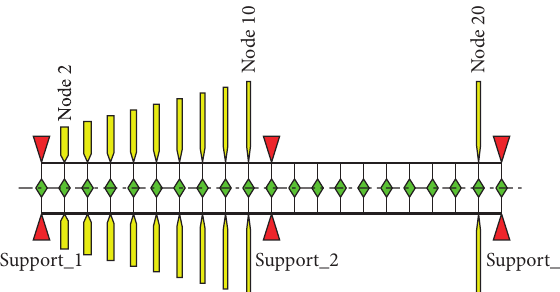
Figure 5: Finite element model of the rotor system.